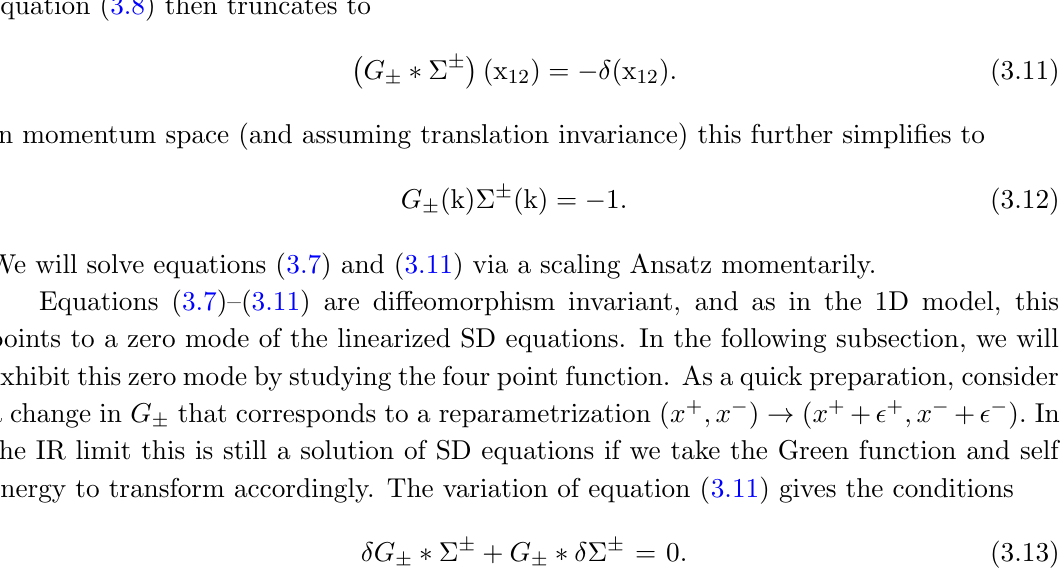
Figure 2 . Diagrammatic representation of the SD equations (3.7), (3.8) and (3.9) for q = 2. where each line with a blob represents a dressed propagator G fermion. The color of the blob represents whether it is a + (blue) or a The SD equations for q = 2 are then depicted as in (cid:12)gure 2. The left-hand side denotes each inverse propagator, while (cid:12)rst term on the right-hand side denotes the self-energy. The second term is the contribution from the dynamical kinetic term, which takes the form of a tadpole diagram attached via an e